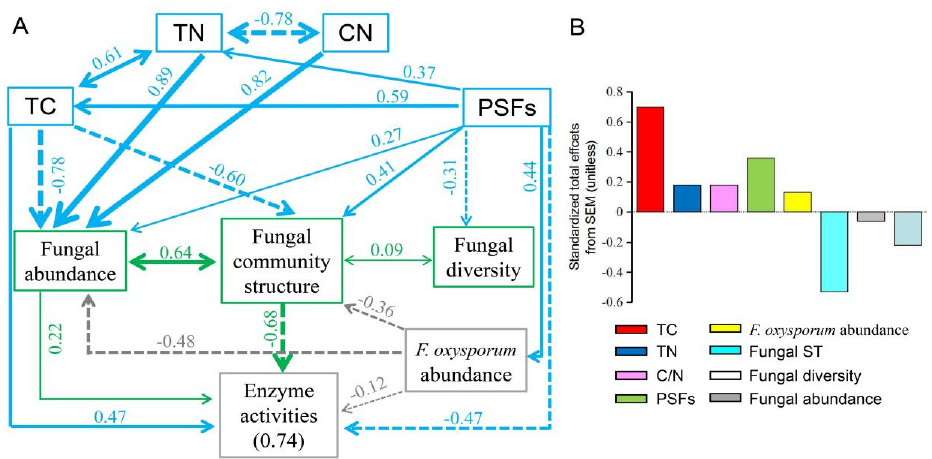
Figure 6. Structural equation modeling (SEM) showed the direct and indirect effects of the fungal diversity, abundance and community structure on the enzyme activities in the soils in panel ( A ). Panel ( B ) shows the standardized total effects of each individual driver. Continuous and dashed arrows indicate positive ( p < 0.05) and negative ( p < 0.05) relationships, respectively. The blue, green and gray arrows represent the paths of the physiochemical factors, fungal diversity, abundance and community structure, respectively. The numbers following the included variables show the explained percentage of its variance by its predictors. The numbers on the arrows are standardized path coefficients. The models fit the data well. Model fits are given in Table S5. TC, soil total carbon; TN, soil total nitrogen; C/N, C, N ratio; PSFs, the composition of soil particle-size fractions; and Fungal ST, fungal community structure.